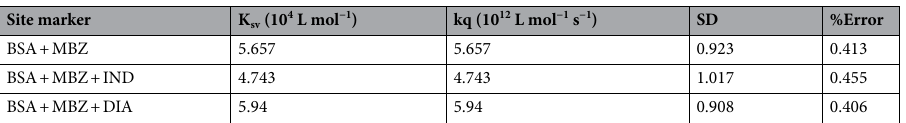
Table 4. Stern volmer quenching constants and bimolecular quenching rate constants for MBZ- BSA interaction in presence of site markers.